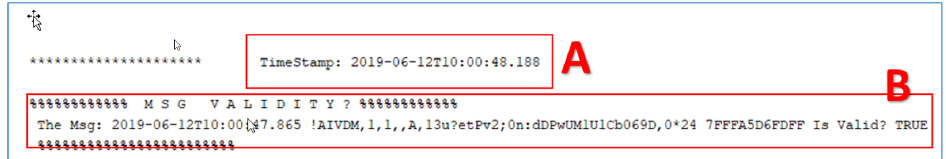
Figure 7. Timestamp ( A ) and signature validity check ( B